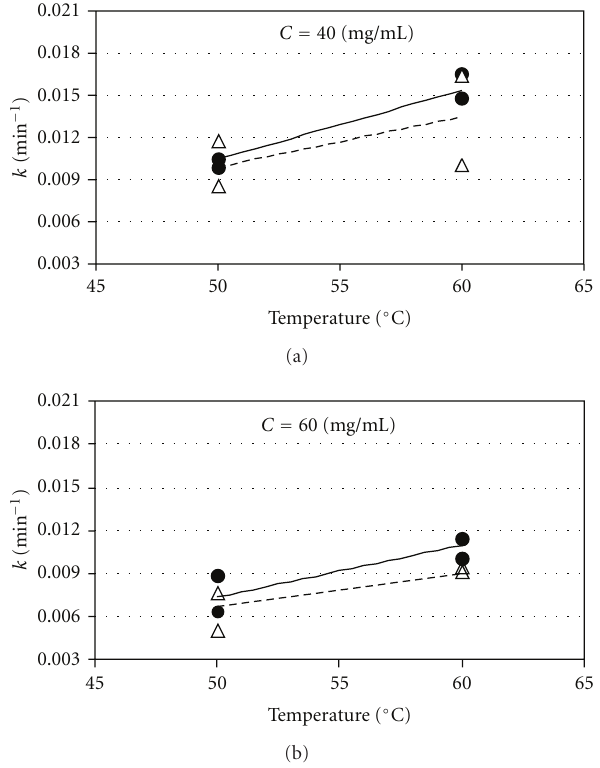
Figure 6: Variation of the rate constant k with temperature (a,b). • Chicory inulin; Δ Agave